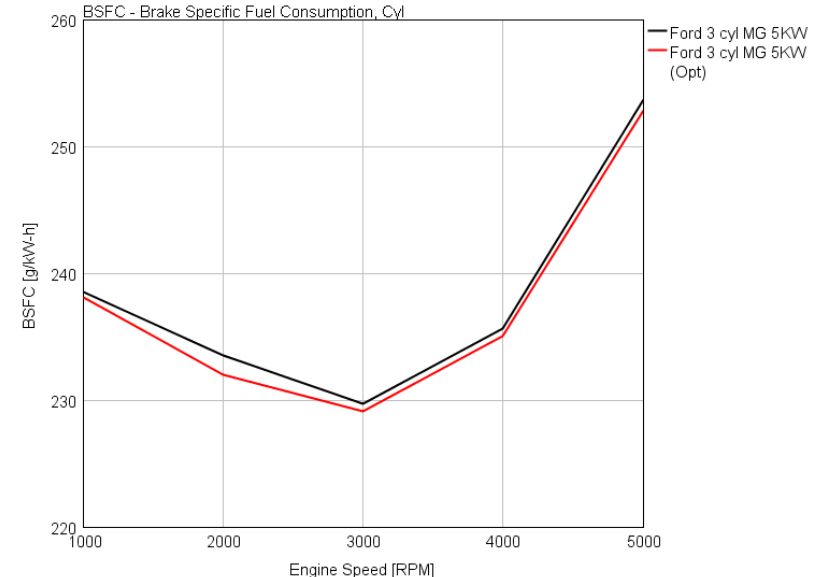
Figure 29. Brake-specific fuel consumption (BSFC) graphs for the initial and optimized electrically